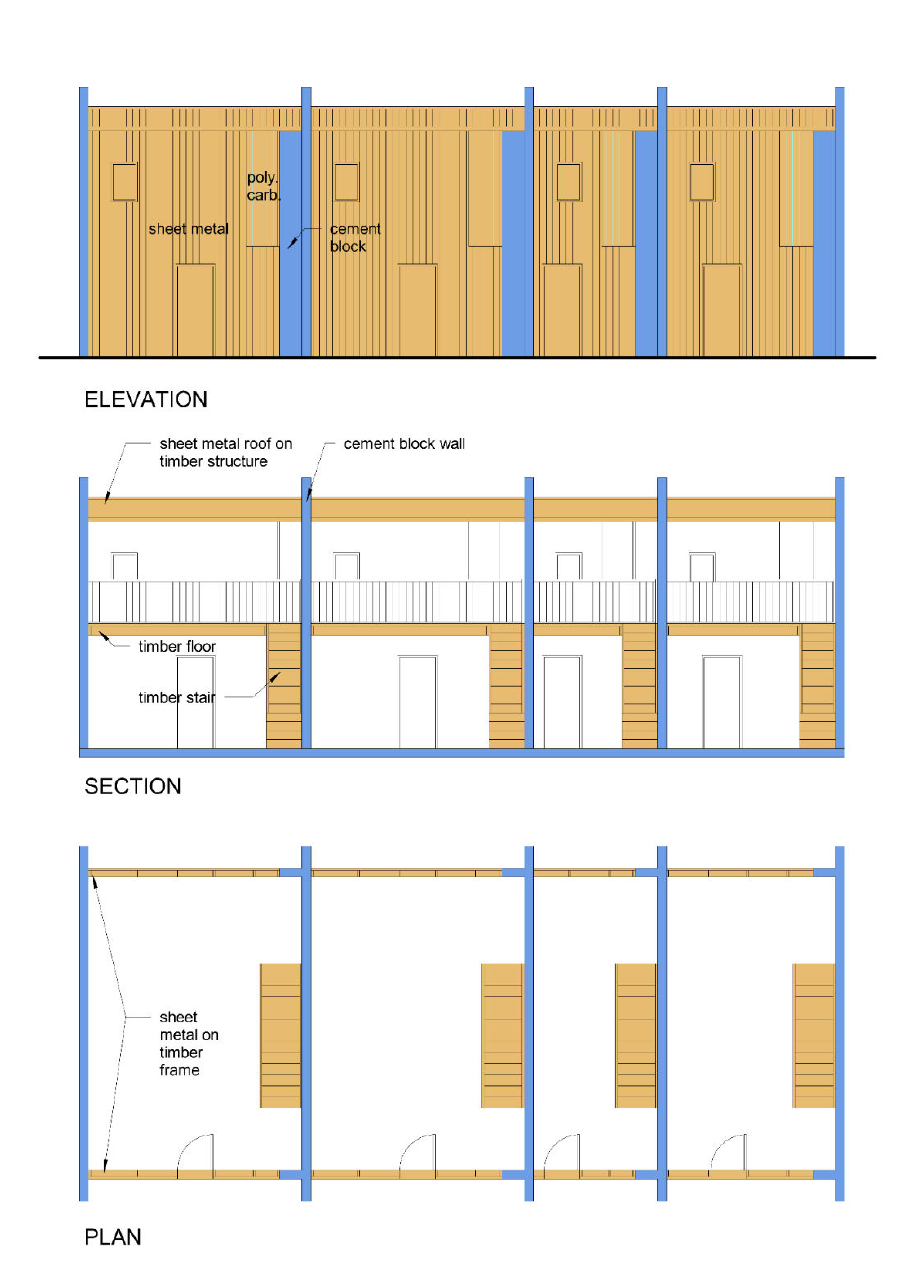
Figure 7: Elevation, section, and plan of the Empower Shack illustrating the hard structure in blue and the softer structure the occupant can readily adapt. By author, 2022. The delivered structure includes the foundations, the ground floor surfaced, firewalls made from concrete blocks, and the roof. Along with these rigid elements, is also the internal first floor with a staircase made from timber. The construction also includes an initial secondary structure to fill in the envelope. These infill walls are made from a timber frame structure with sheet metal and polycarbonate cladding and include an entrance door and an openable window on the first floor. The occupant can further develop the interior of the unit with the materials and technologies at their disposal. Timber construction is easier to manipulate compared to concrete or brick structures. Occupants can redefine and build onto the envelope ’ s infill